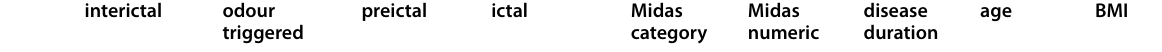
113 patients with migraine. Migraine-related impairment in daily life: =